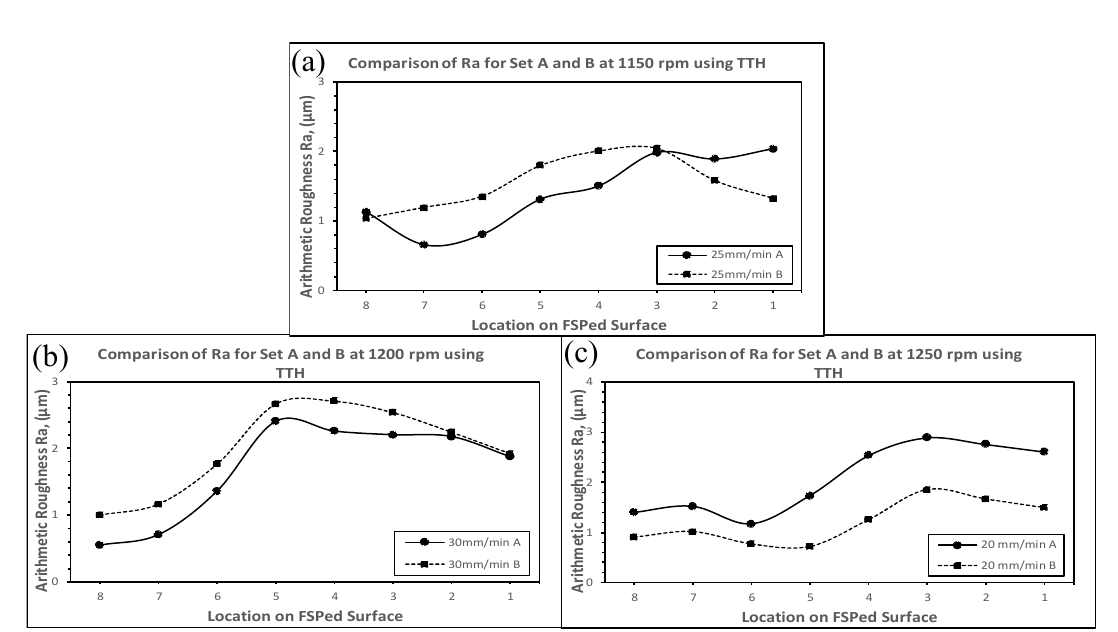
Figure 15. Comparison between Set A and Set B using TTH tool at, ( a ) 1150 rpm, 25 mm/min, ( b ) 1200 rpm, 30 mm/min, and ( c ) 1250 rpm, 20 mm/min.